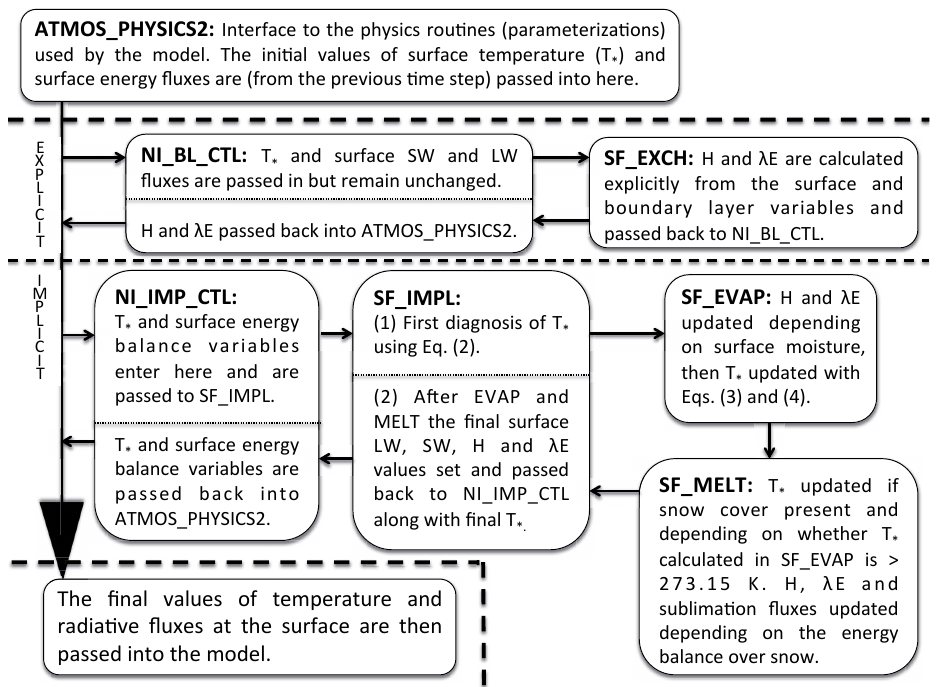
Figure 1. Schematic diagram of the processes involved with calculating the surface temperature and fluxes in ACCESS. Upper-case lettering refers to the names of individual subroutines within the model. The variables are passed from ATMOS_PHYSICS2 through the explicit calculations, then the implicit calculations, and finally back to ATMOS_PHYSICS2 for use elsewhere. Arrows indicate the transfer of variables through subroutines. Solid lines separate the transfer of variables into and out of the same subroutine where